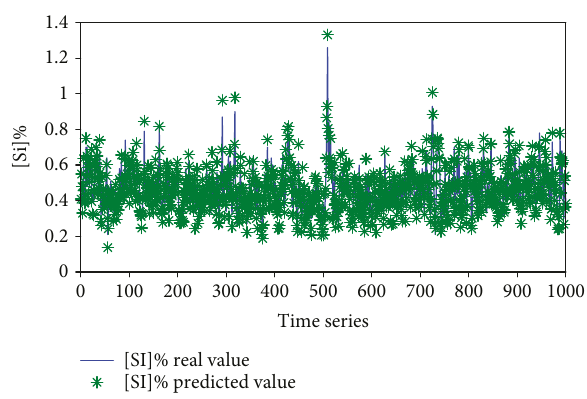
Figure 8: Comparison of dynamic prediction results and actual values of [Si]